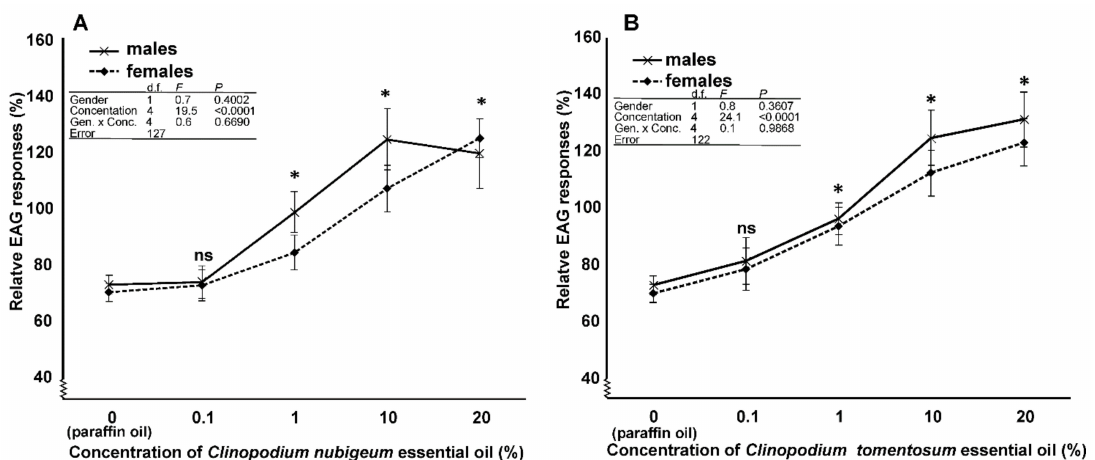
Figure 11. Dose–response relationships for stimulation of male and female antennae of Sitophilus zeamais with Clinopodium nubigenum ( A ) and C. tomentosum ( B ) essential oils. Data (mean ± standard error) represent the EAG response relative to octanal (%). Table insets show the statistical parameters of two-way ANOVA. The response of the two gender to each compound is compared to those of the control (para ffi n oil) (*, p < 0.05; ns, not significant; ANOVA, Dunnett post hoc